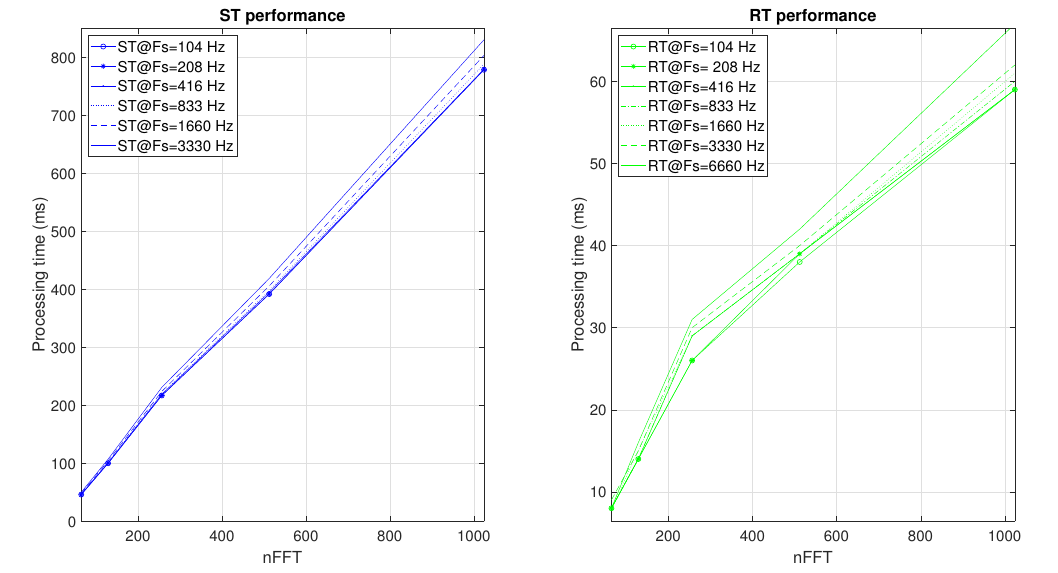
Figure 11. Performance